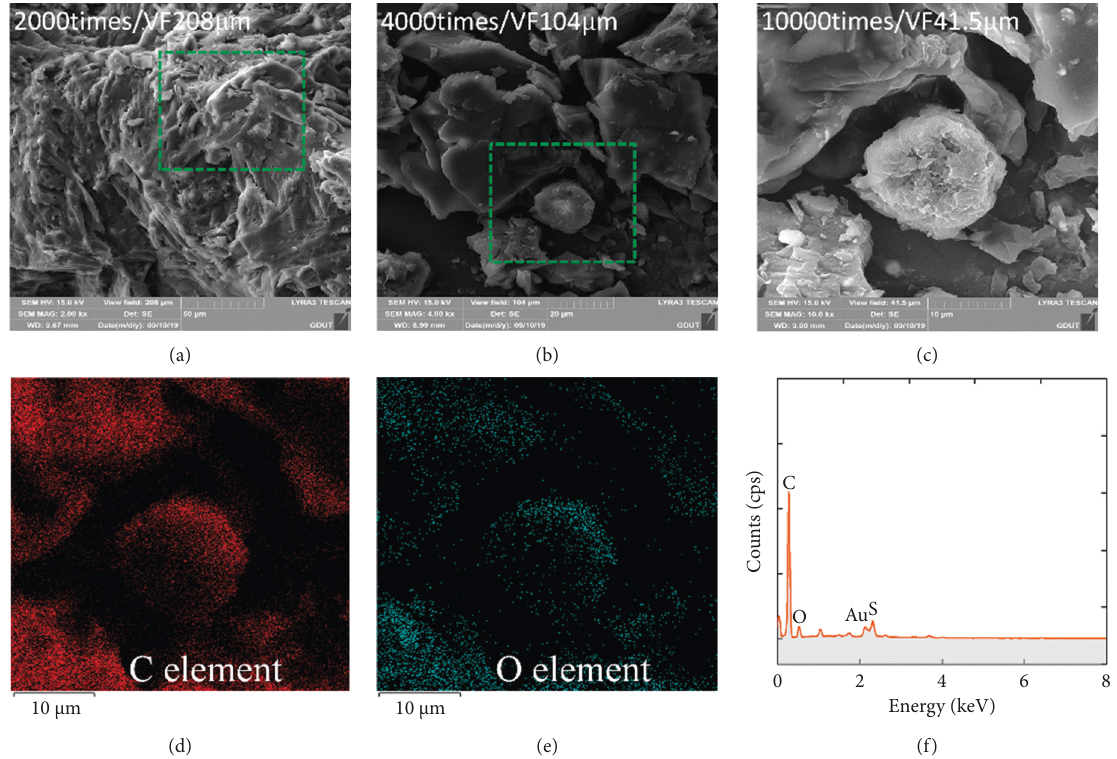
Figure 6: Micromorphology and elemental composition of T770 light stabilizer. (a) 2000 times. (b) 4000 times. (c) 10000 times. (d, e) Element mapping diagrams. (f) EDS energy spectrum.